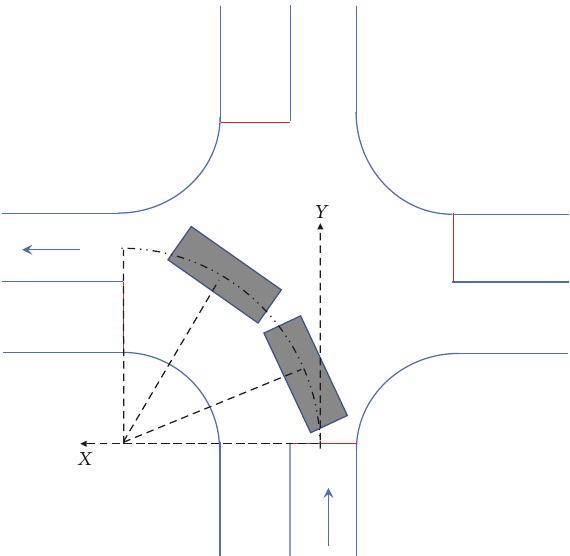
Figure 1: Schematic diagram of leading (veh 𝑙 ) and following (veh 𝑓 ) left-turning